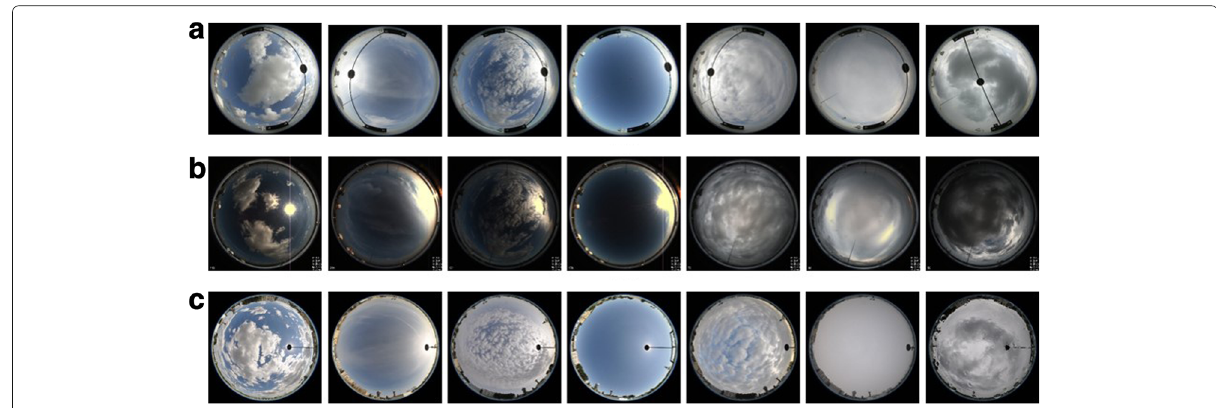
Fig. 4 Cloud samples from a the CAMS_e database, b the IAP_e database, and c the MOC_e